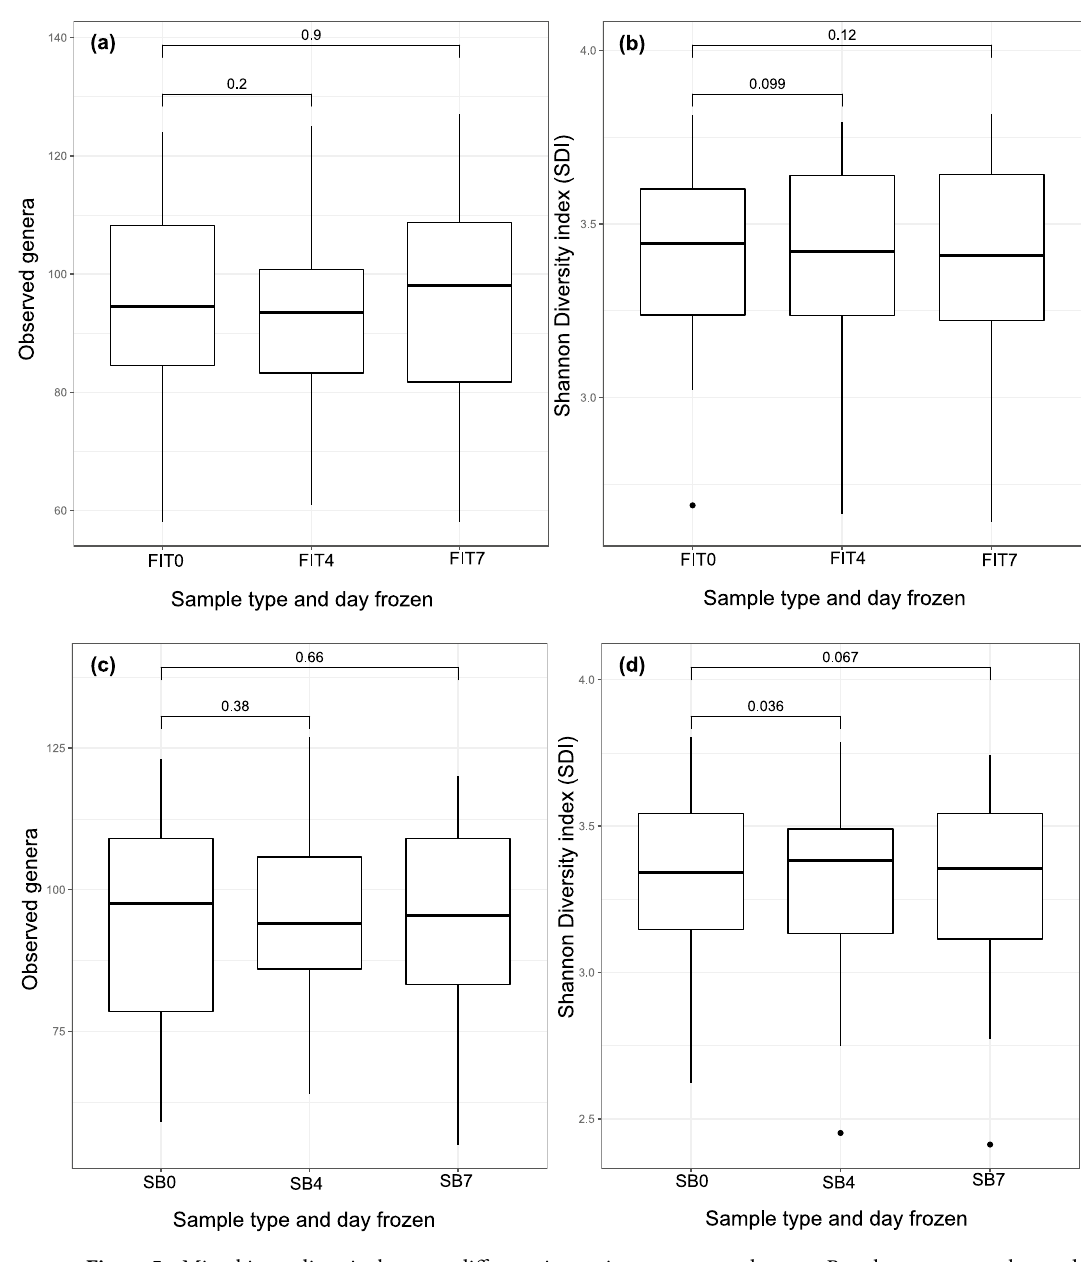
Figure 5. Microbiome diversity between different time points across sample types. Boxplots represent observed the genera ( a ) and Shannon diversity indexes ( b ) of FIT samples and the observed genera ( c ) and Shannon diversity indexes ( d ) of stabilization buffer samples from different time points. FIT0 immediately frozen FIT samples; FIT4 FIT samples frozen on day 4; FIT7 FIT samples frozen on day 7; SB0 immediately frozen stabilization buffer samples; SB4 stabilization buffer samples frozen on day 4; SB7 stabilization buffer samples frozen on day